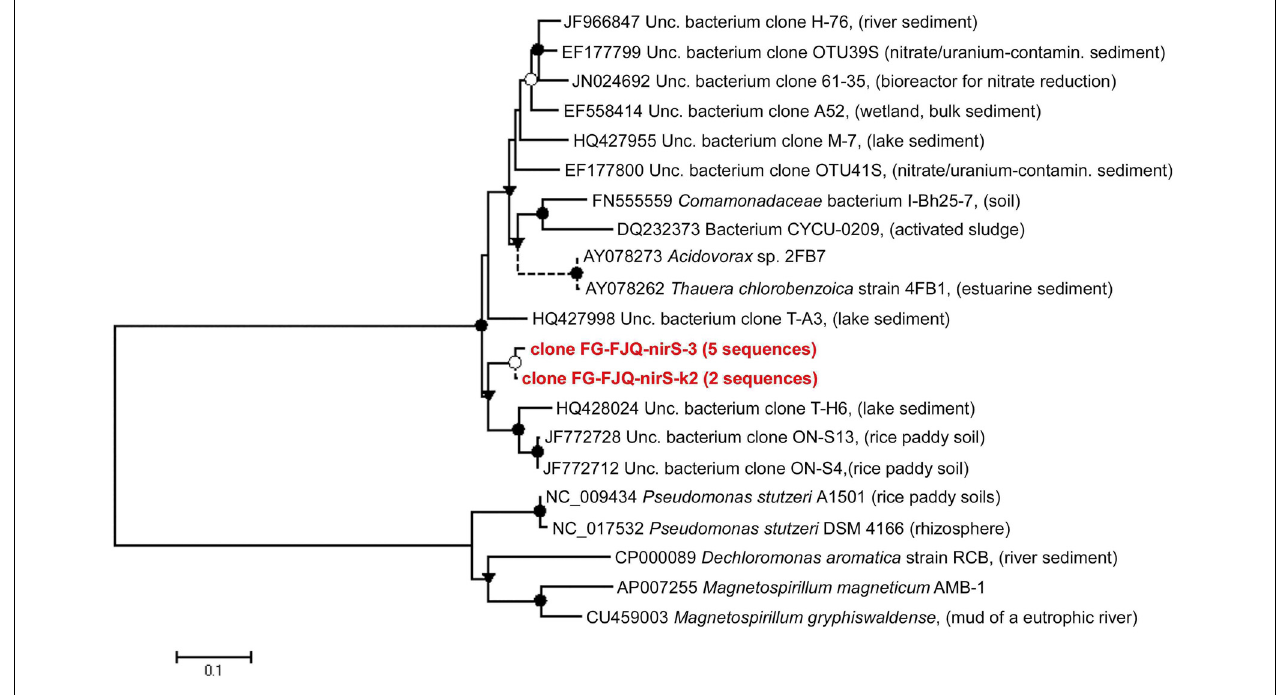
FIGURE 6 | Phylogenetic relationships of nirS gene sequences obtained from microcosms of the spring FJQ. The tree was generated by neighbor-joining analysis of 881 nucleotide positions.